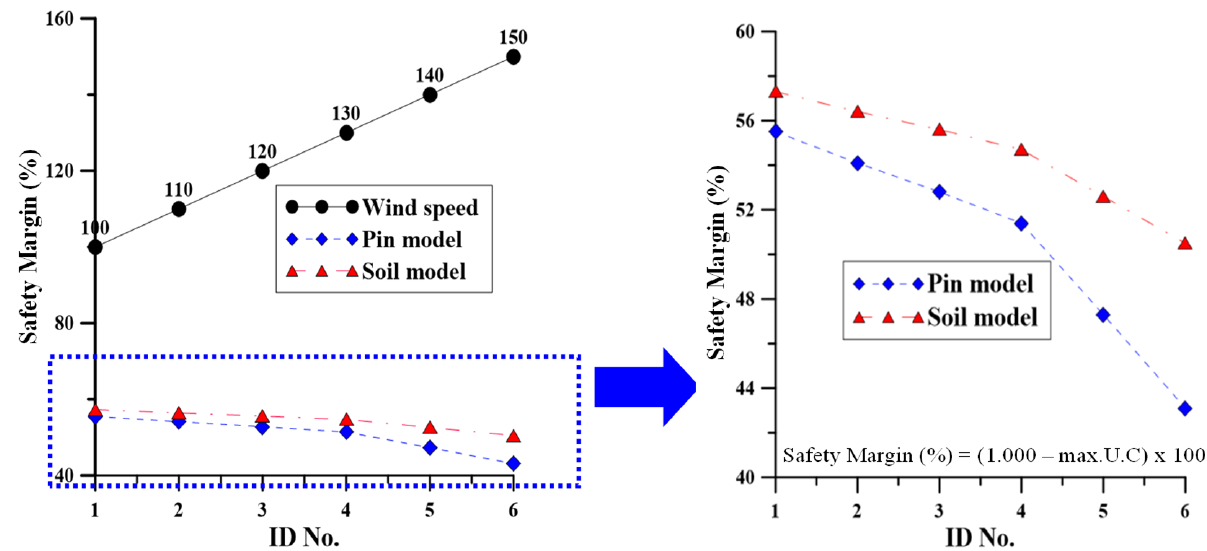
Figure 11. Comparative unit check margin with varying wave speed.